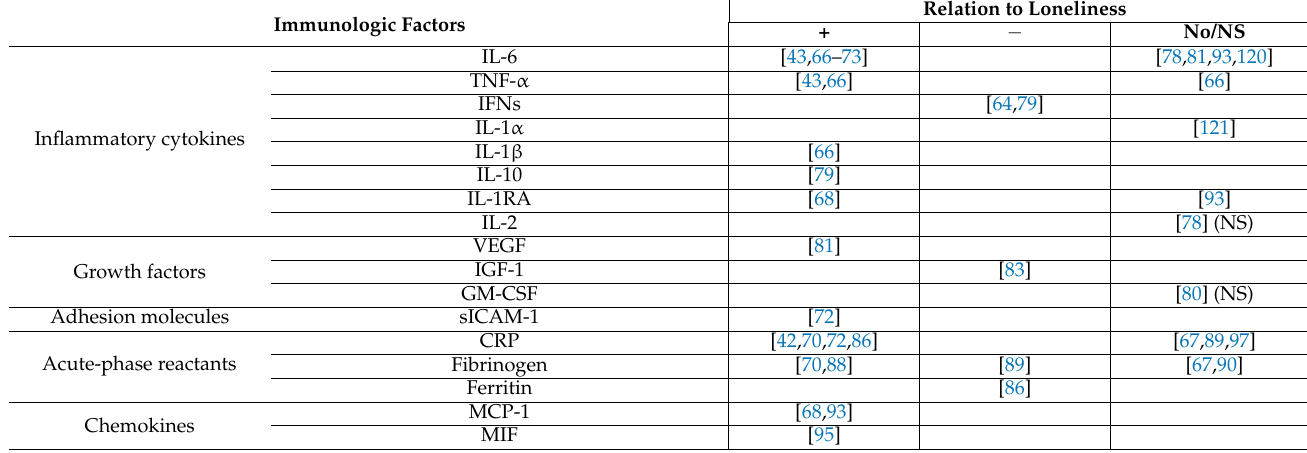
Table 2. An overview of the immunologic factors investigated in relation to